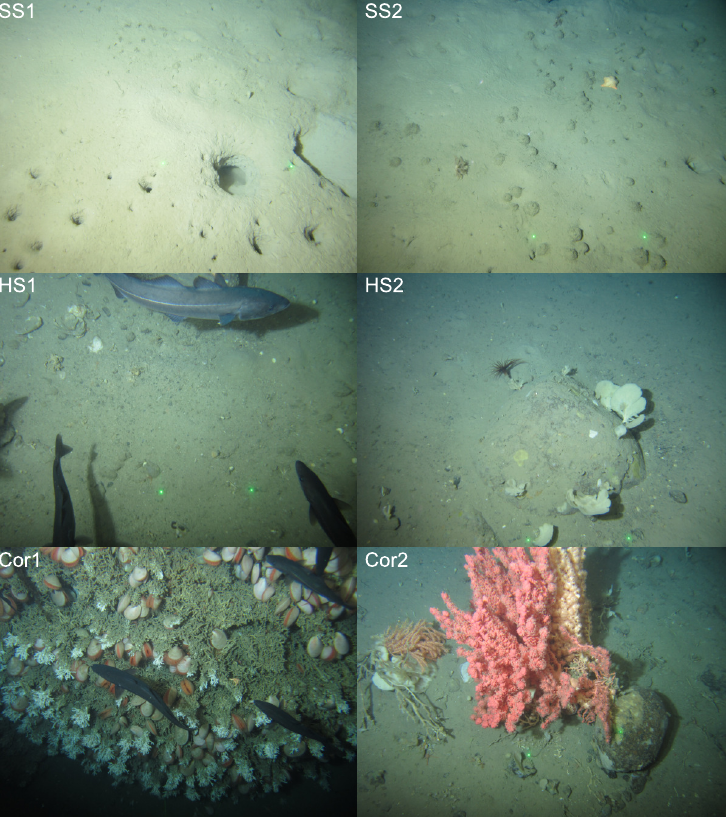
Figure 10. Example of Habitat classes in image dataset: SS1 (Soft Substrate), SS2 (Soft Substrate Sponge Community), HS1 (Hard Substrate), HS2 (Hard Substrate Sponge Community), Cor1 (Reef Framework) and Cor2 (Soft Corals). See Table 1 for further class